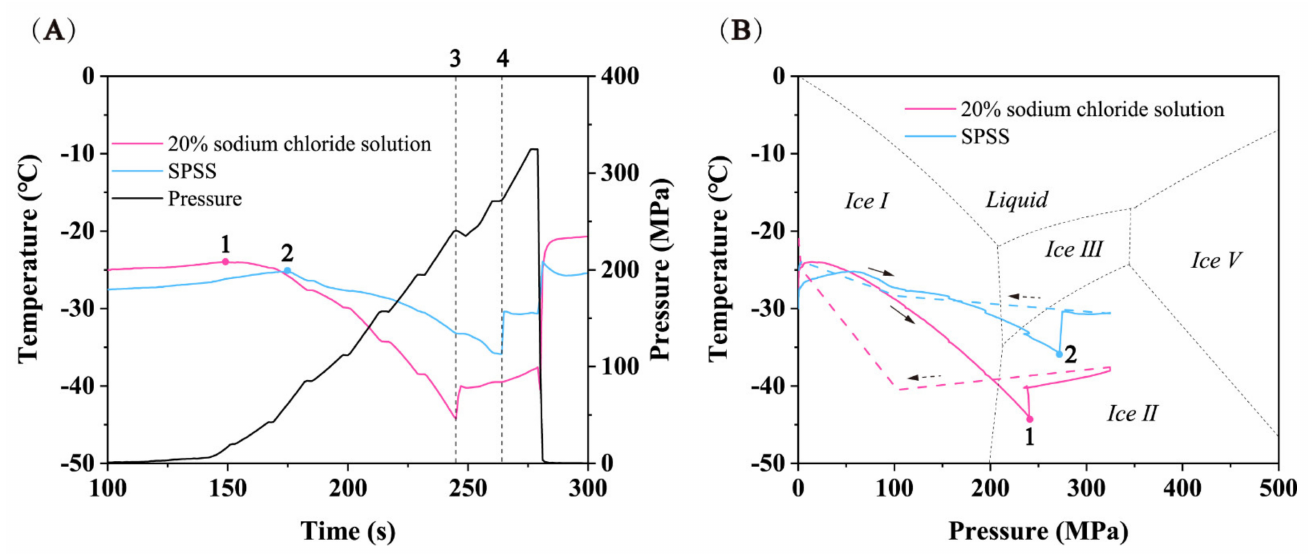
Figure 4. Temperature and pressure paths of frozen inoculated SSPS cooled by 20% sodium chlo- ride solution. ( A ) Temperature and pressure curves over time. ( B ) Temperature-pressure profile superimposed on the phase diagram of water. (—) pressure boost process, (—) pressure relief